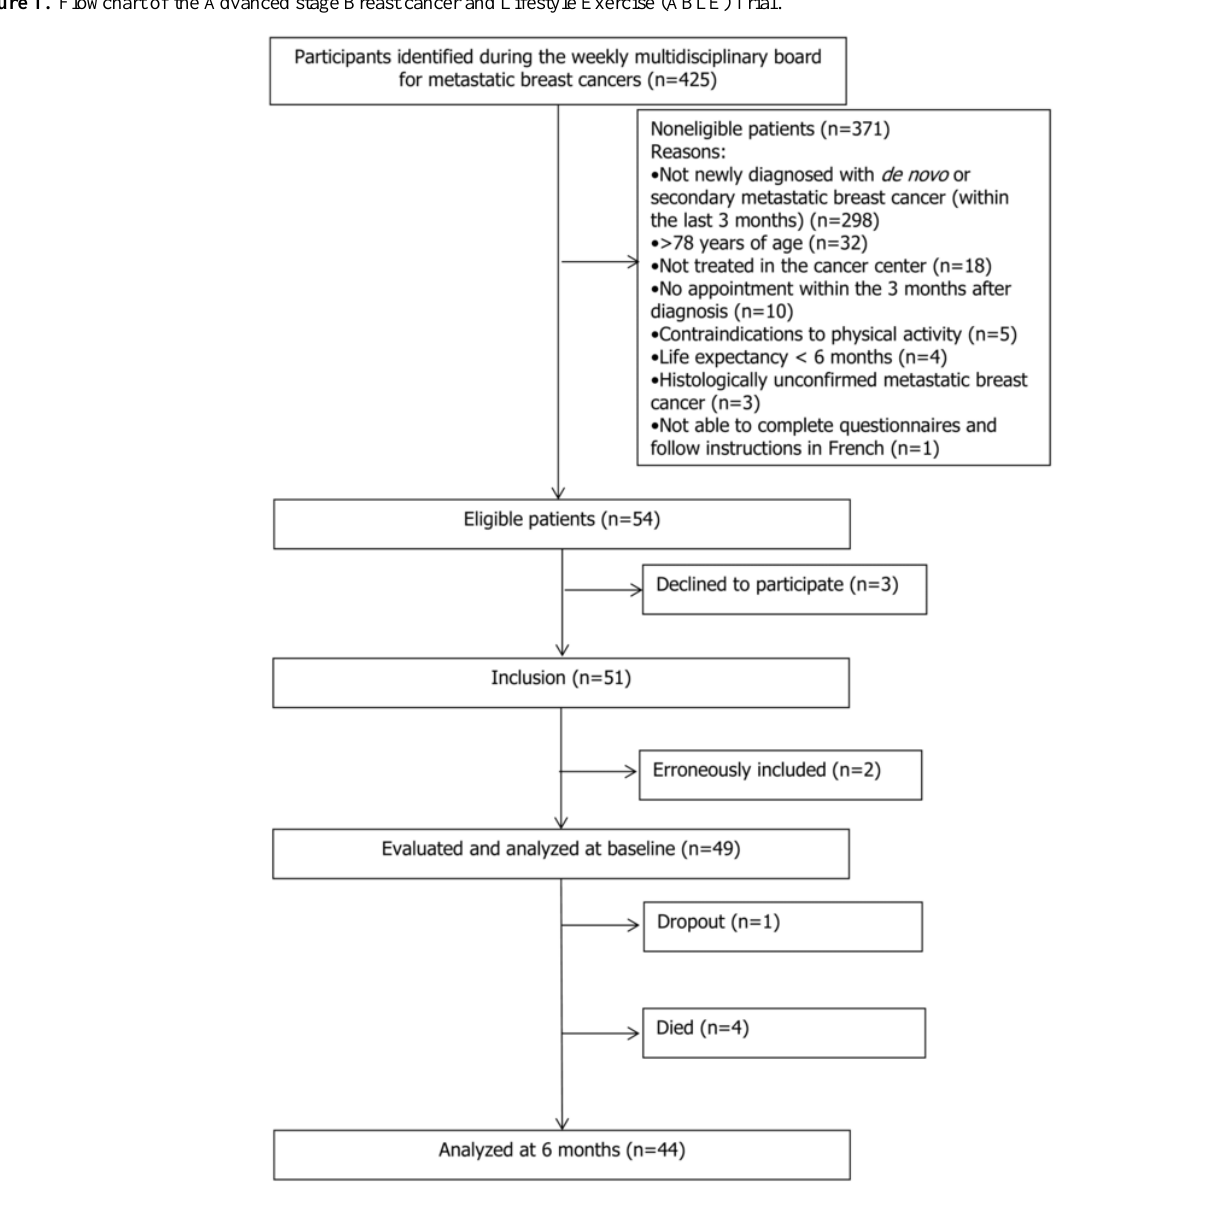
Figure 1. Flowchart of the Advanced stage Breast cancer and Lifestyle Exercise (ABLE)